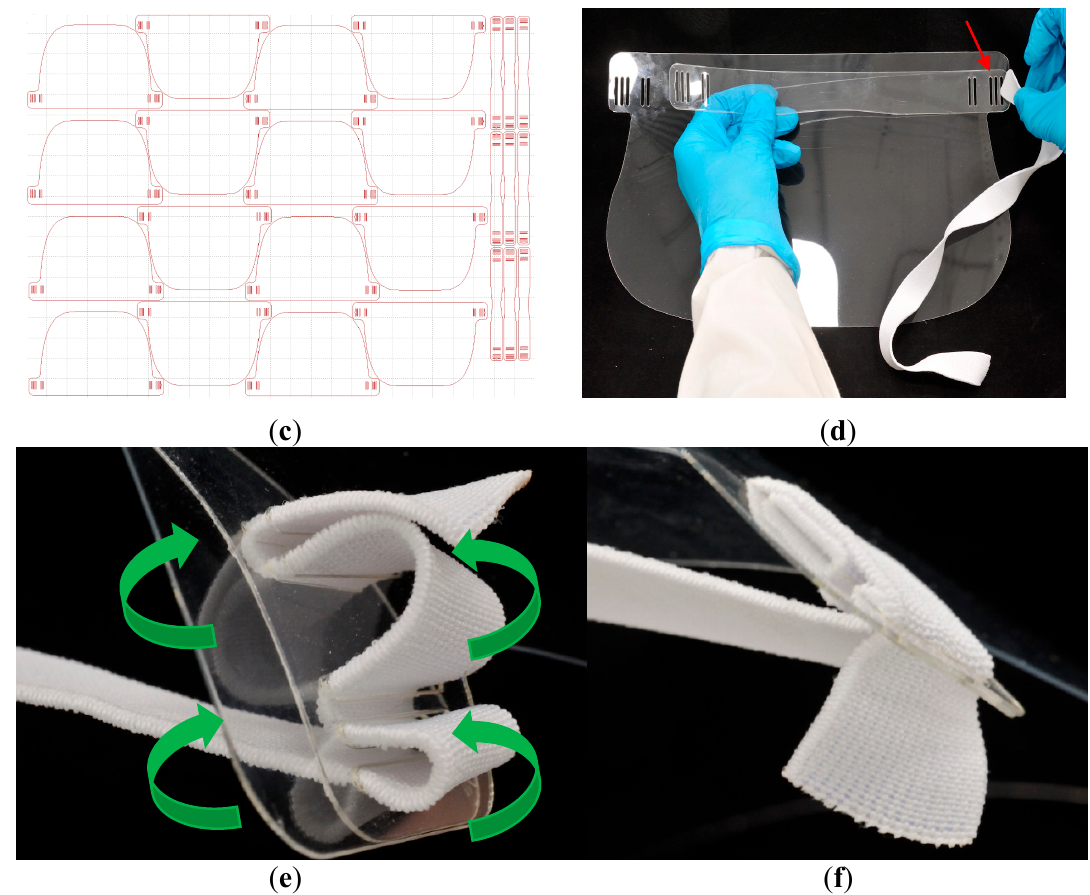
Figure 4. Devised full face transparent shield: stages of fabrication: ( a ) ready product; ( b ) pattern for laser cutting of L vs. S size; ( c ) laser cutting S size template example less than 8 min total; ( d , e ) assembling of forehead strip and front visor together with fabric elastic band; ( f ) adjusted band length to maintain comfort pressure.